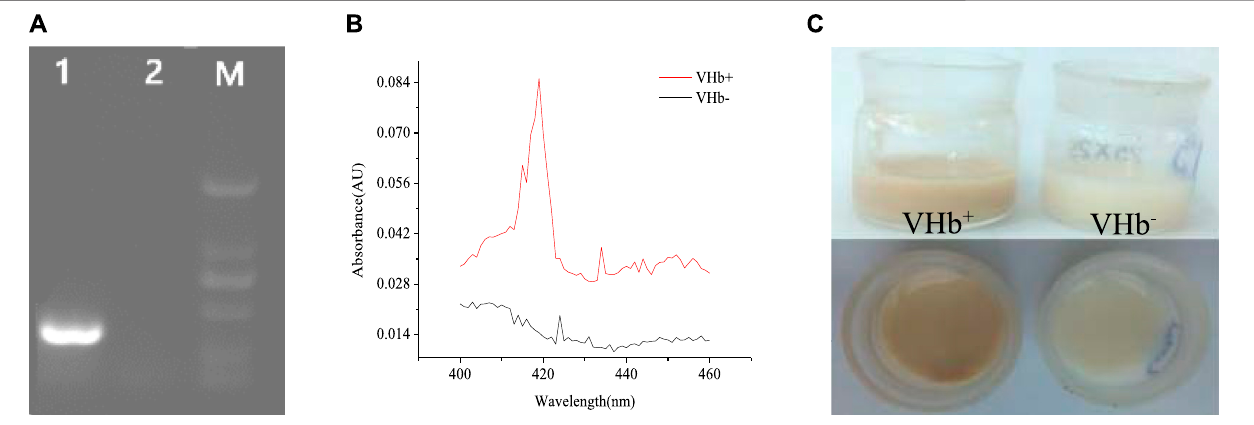
FIGURE 2 | Phenotypic analysis of the S. bombicola vgb strain. (A) Electrophoresis analysis of genomic DNA extracted from wild-type strains Vitreoscilla hemoglobin (VHb − ) and transformants (VHb + ) of S. bombicola . Lane 1: VHb + (441 bp); Lane 2: VHb − (wild-type strain); Lane M: DL 2000 DNA marker (2000